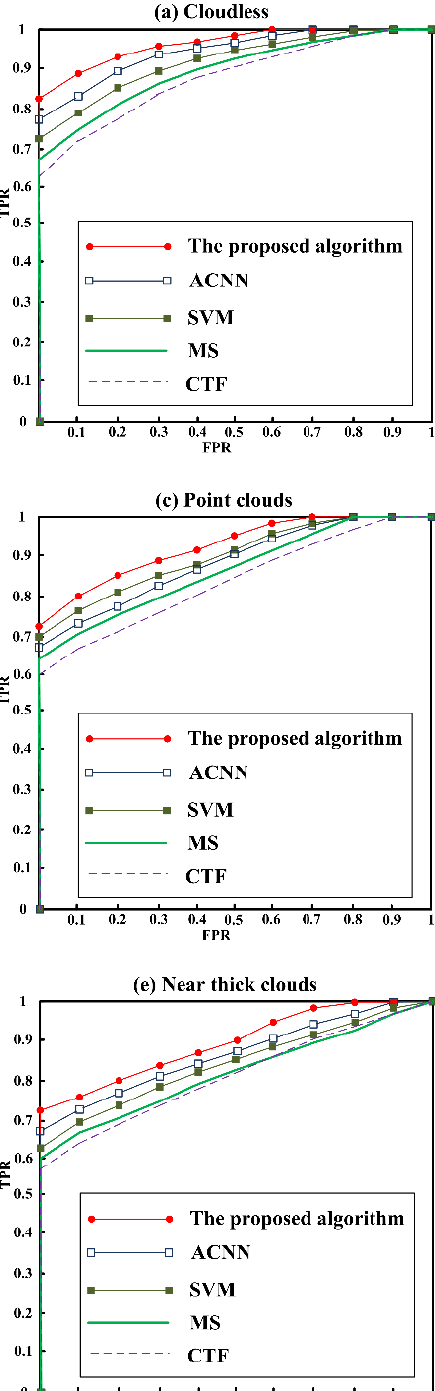
19 of 27 Table 3. Cloud detection results of database 2. Algorithm 0.86 Table 4. Cloud detection results of database 3. Algorithm